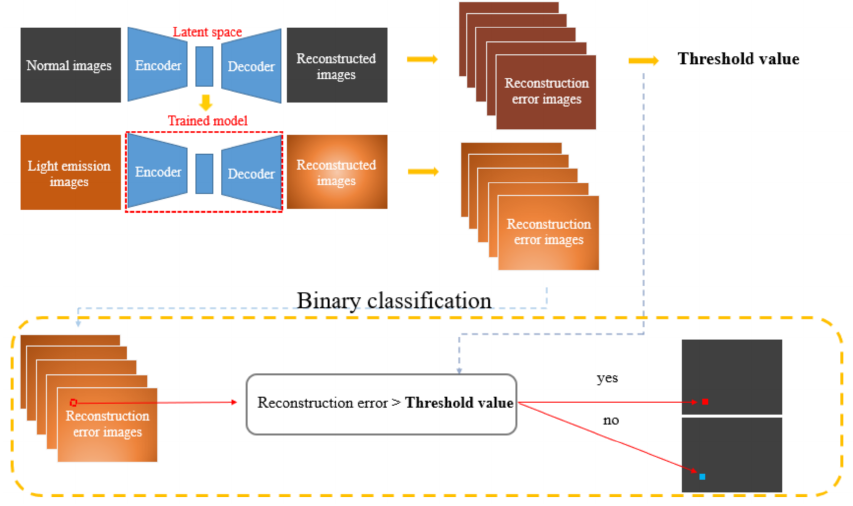
Figure 7. Schematic process of binary classification using the threshold value.